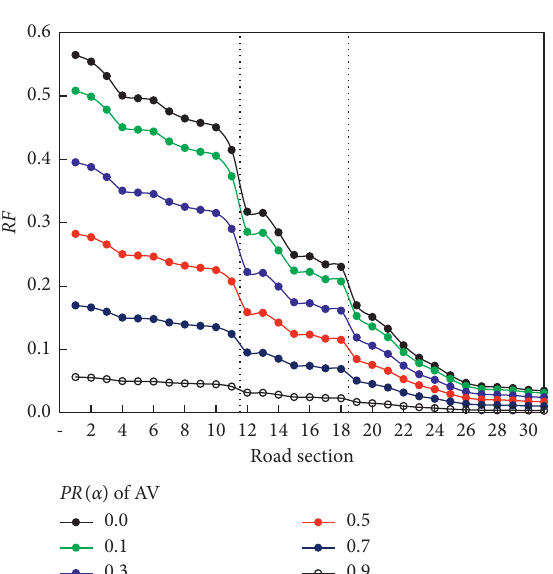
Figure 8: Effects of PR of high-level AV on the reduction of RF .